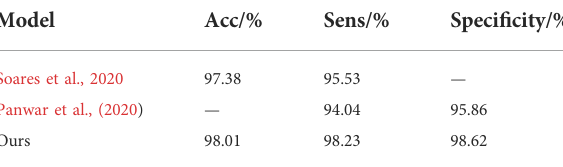
TABLE 4 Model comparison of SARS-CoV-2 CT-scan dataset.